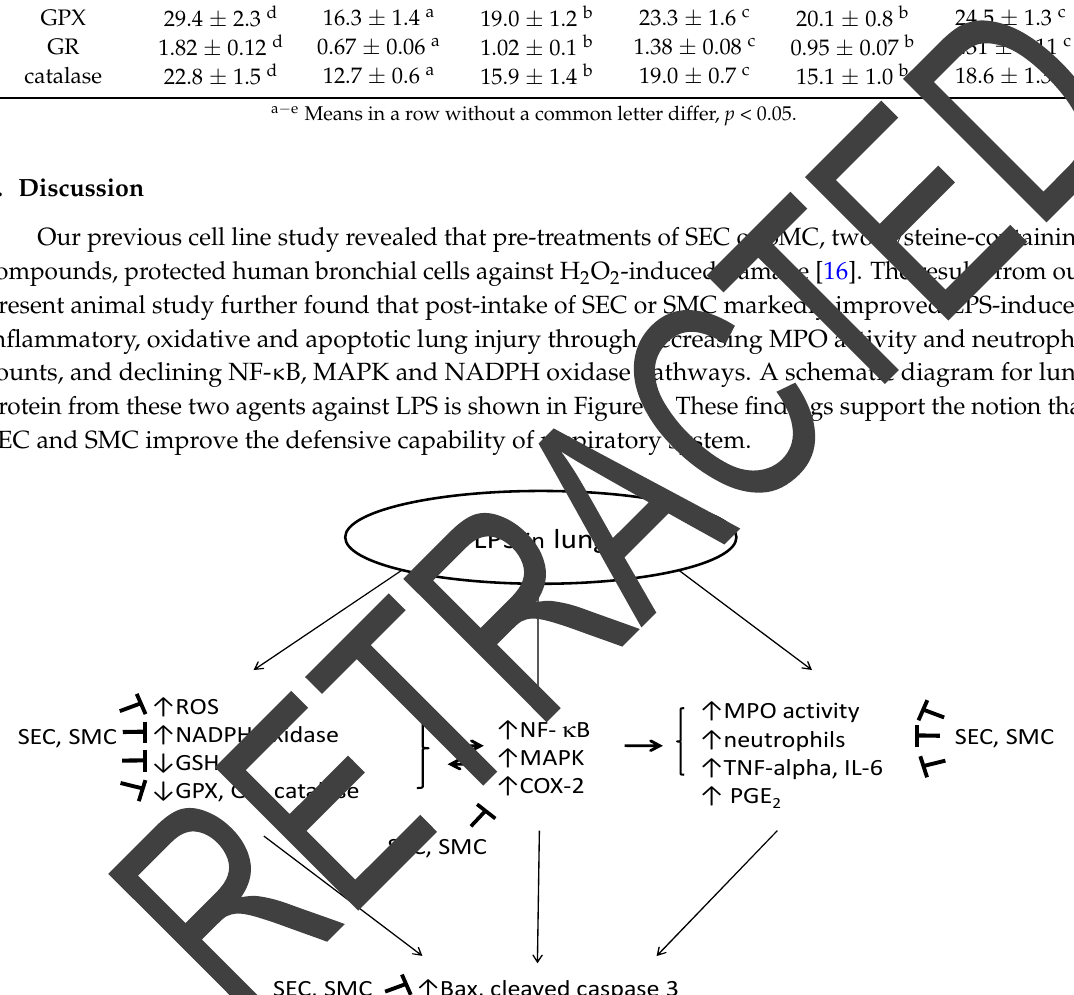
Figure 5. Schematic diagram for lung protein of SEC or SMC against LPS.